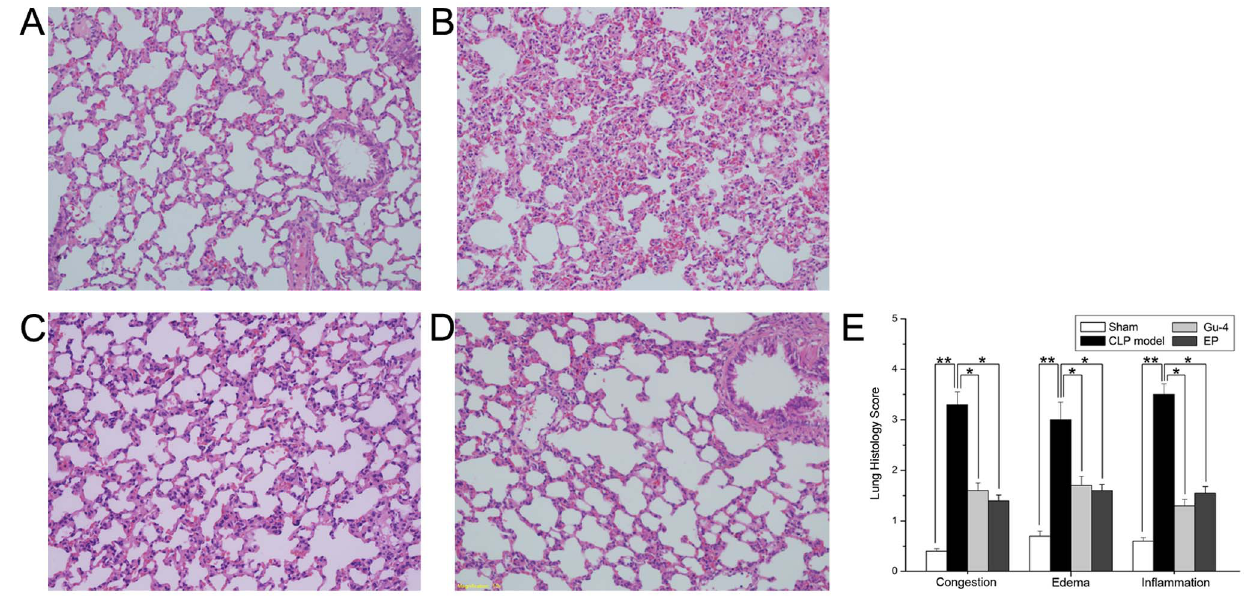
Figure 2. Effects of Gu-4 treatment on lung injury in rats with CLP-induced sepsis. Ten hours after CLP, lung tissues from sham control rats (A), saline treated CLP rats (B), Gu-4 treated CLP rats (C) and EP treated CLP rats (D) were collected and subjected to Hematoxylin and Eosin staining and examined by light microscopy (magnification, 6 100). Histological scoring of lung injury were evaluated based on aspects of congestion, edema and inflammation E: The lung injury seriously induced by CLP was greatly attenuated by Gu-4 treatment. Data in E are expressed as mean 6 S.D. (n=5 rat/group) *, p , 0.05; **, p , 0.01.